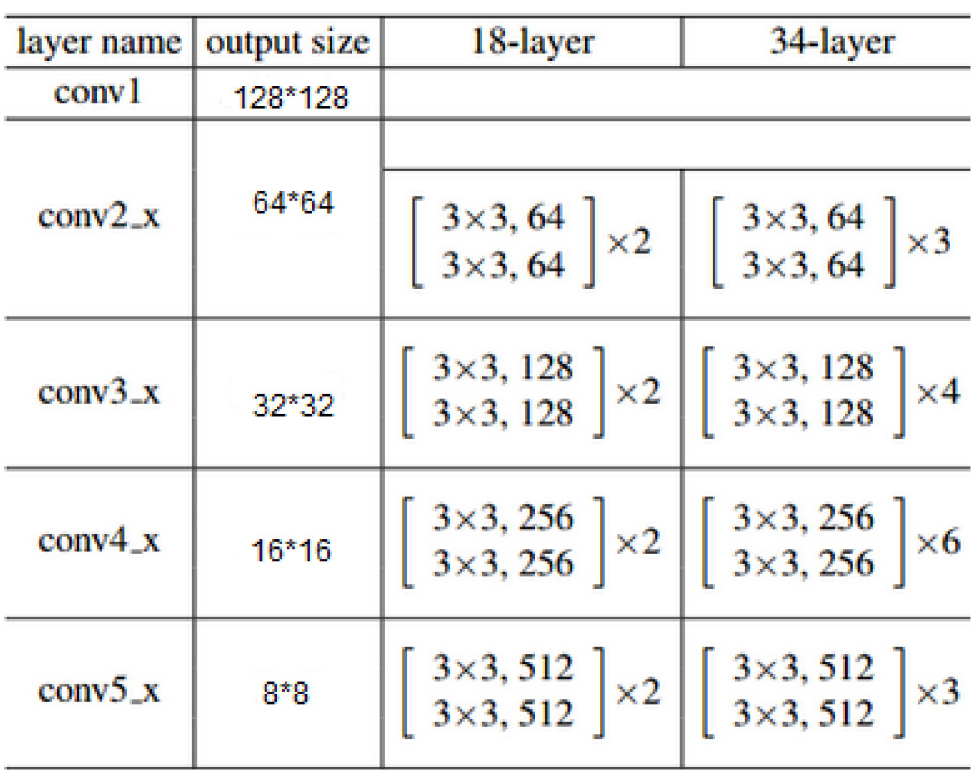
Fig 1. The structure of the Resnet-18 and Resnet-34